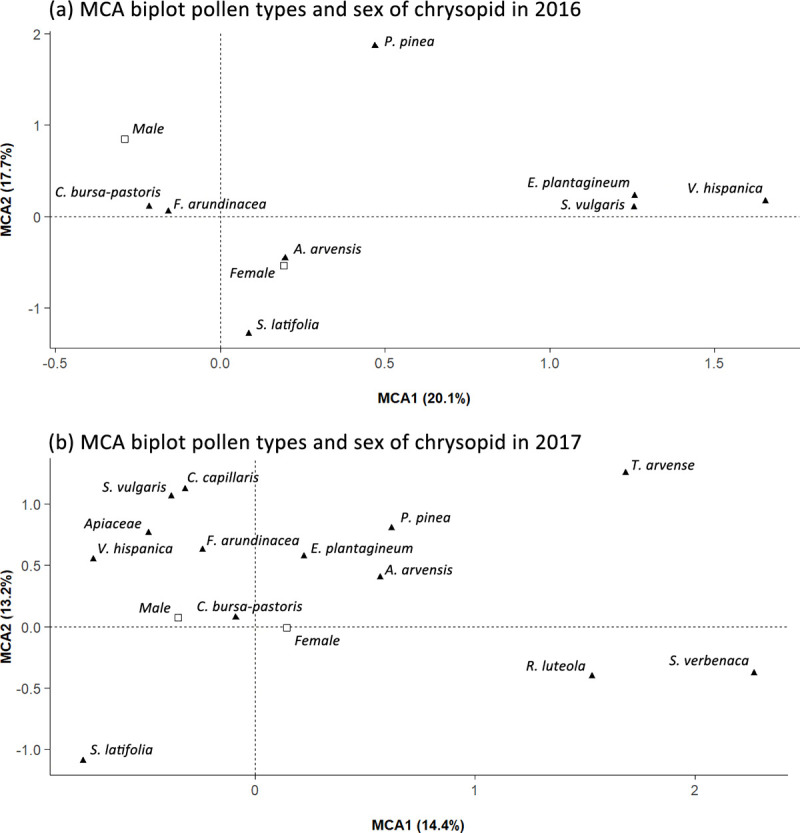
MCA biplot shows the association between the pollen types identified (▲) and sex of chrysopids (□) in 2016 (a) and 2017 (b).